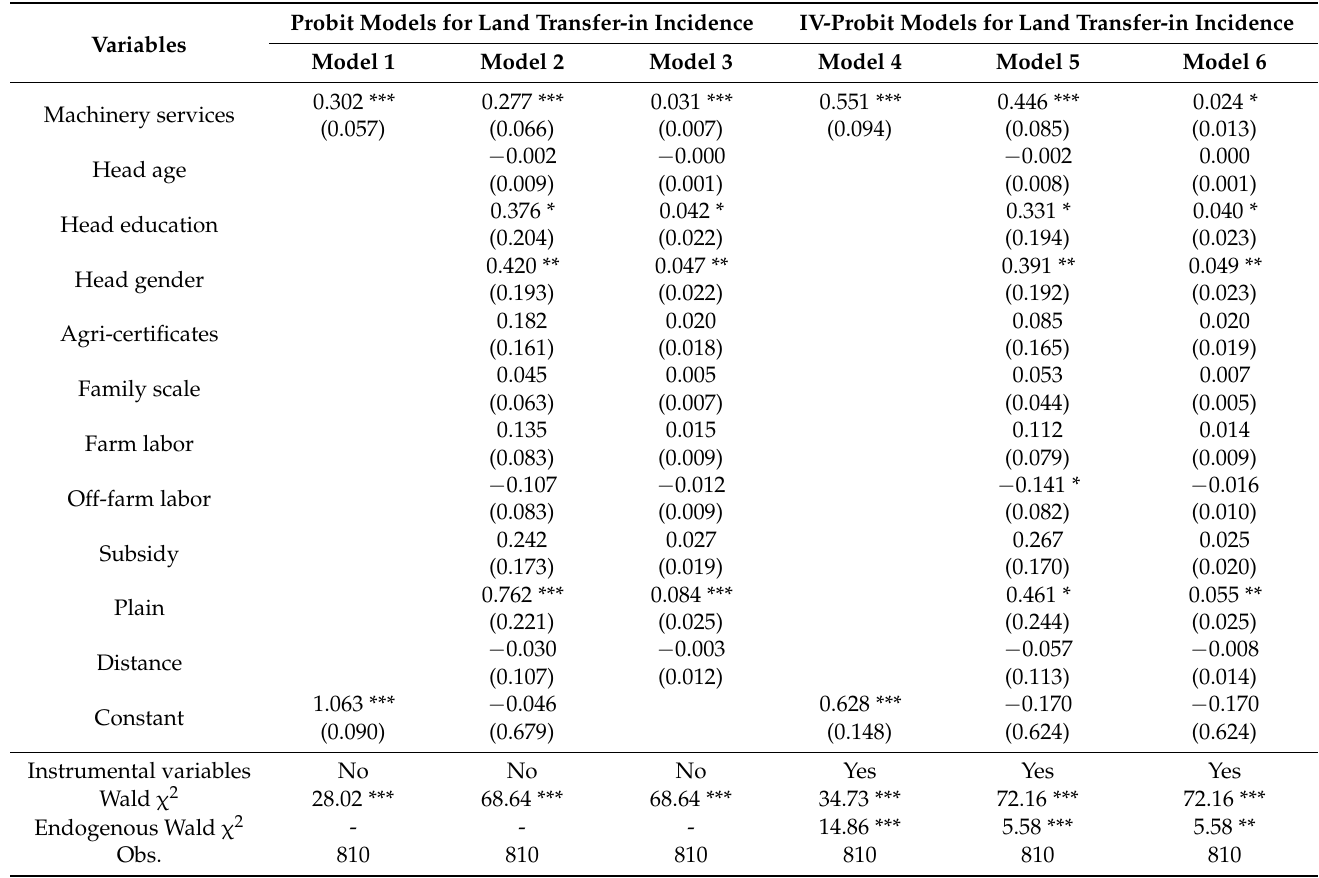
Table 3. The impact of agricultural machinery services on farmers’ land transfer-in incidence.